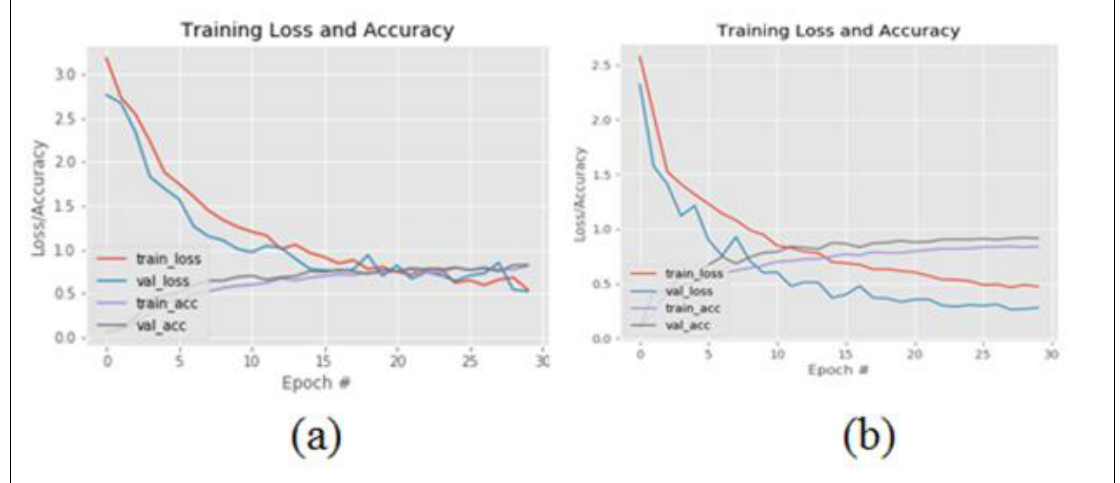
Figure 5: Training and validataion result (a) AlexNet (b) GoogleNet Source: Authors, (2021).